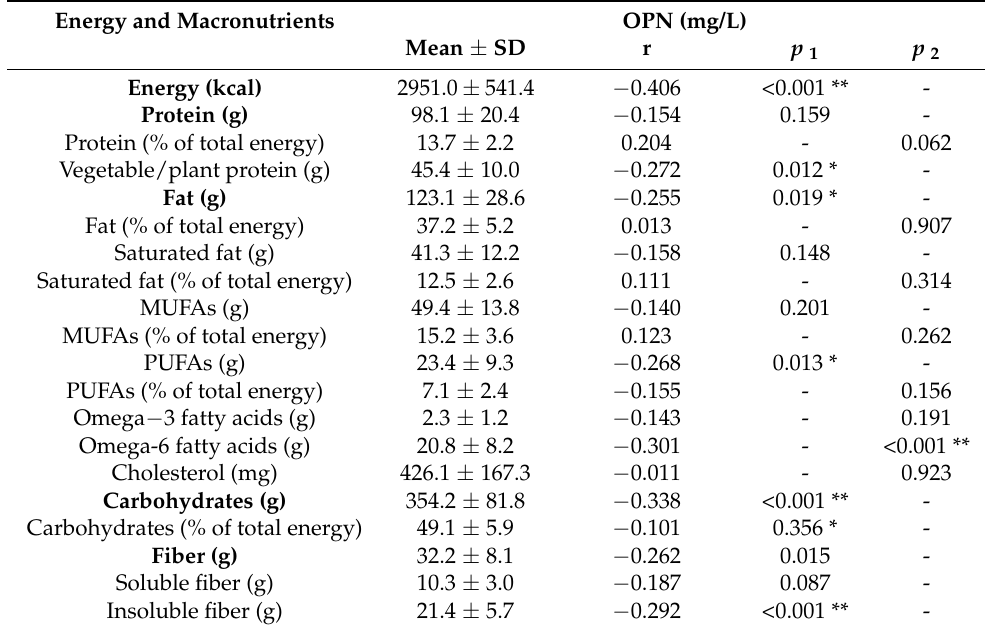
Carbohydrates (g)